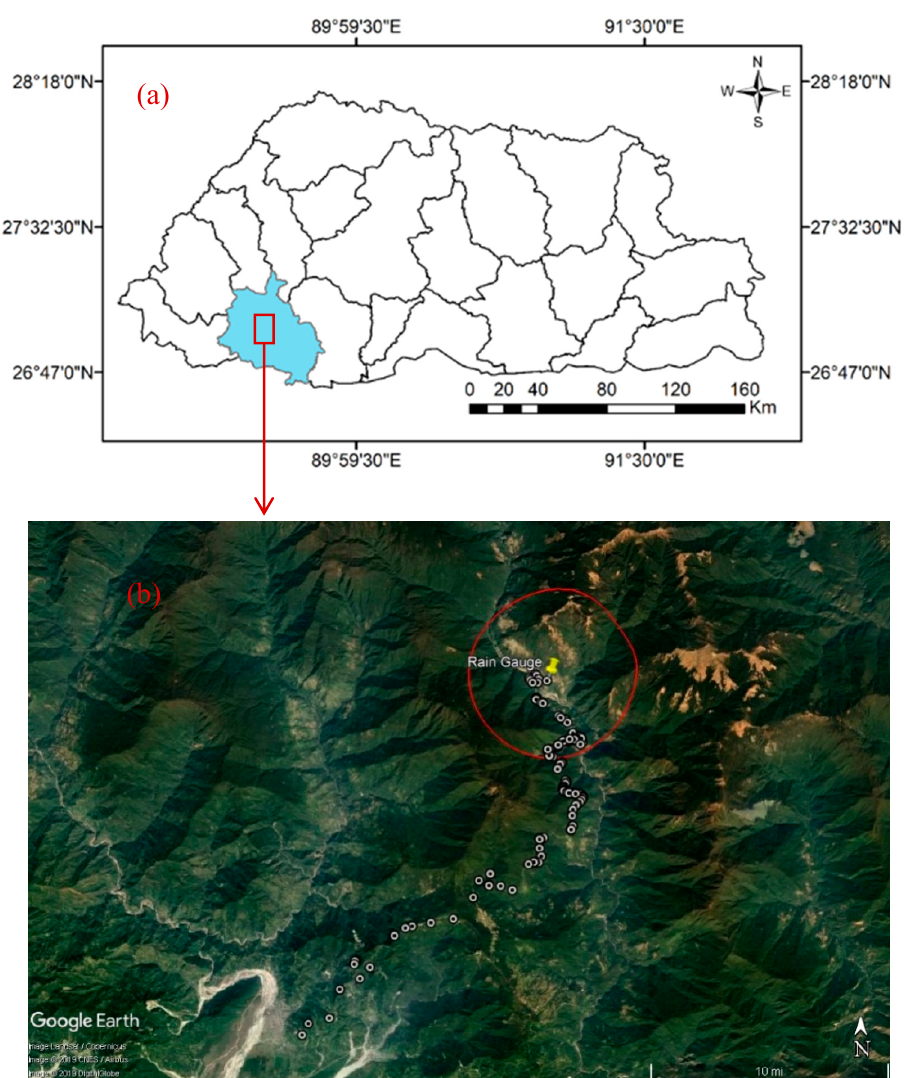
Figure 1. Location of ( a ) Bhutan ( b ) spatial distribution of landslides considered for analysis.